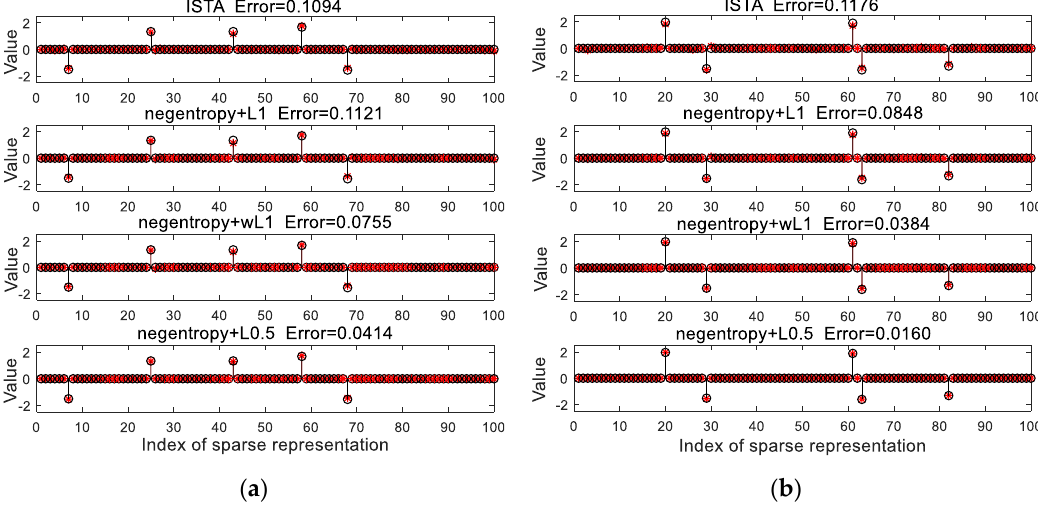
Figure 1. Comparison between original signal (black) and recovered signal (red): ( a ) with Gaussian noise; ( b ) with non-Gaussian noise.